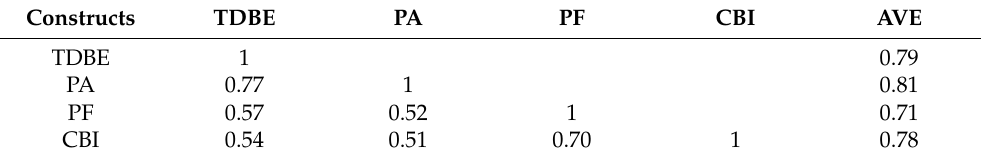
Table 3. Discriminant